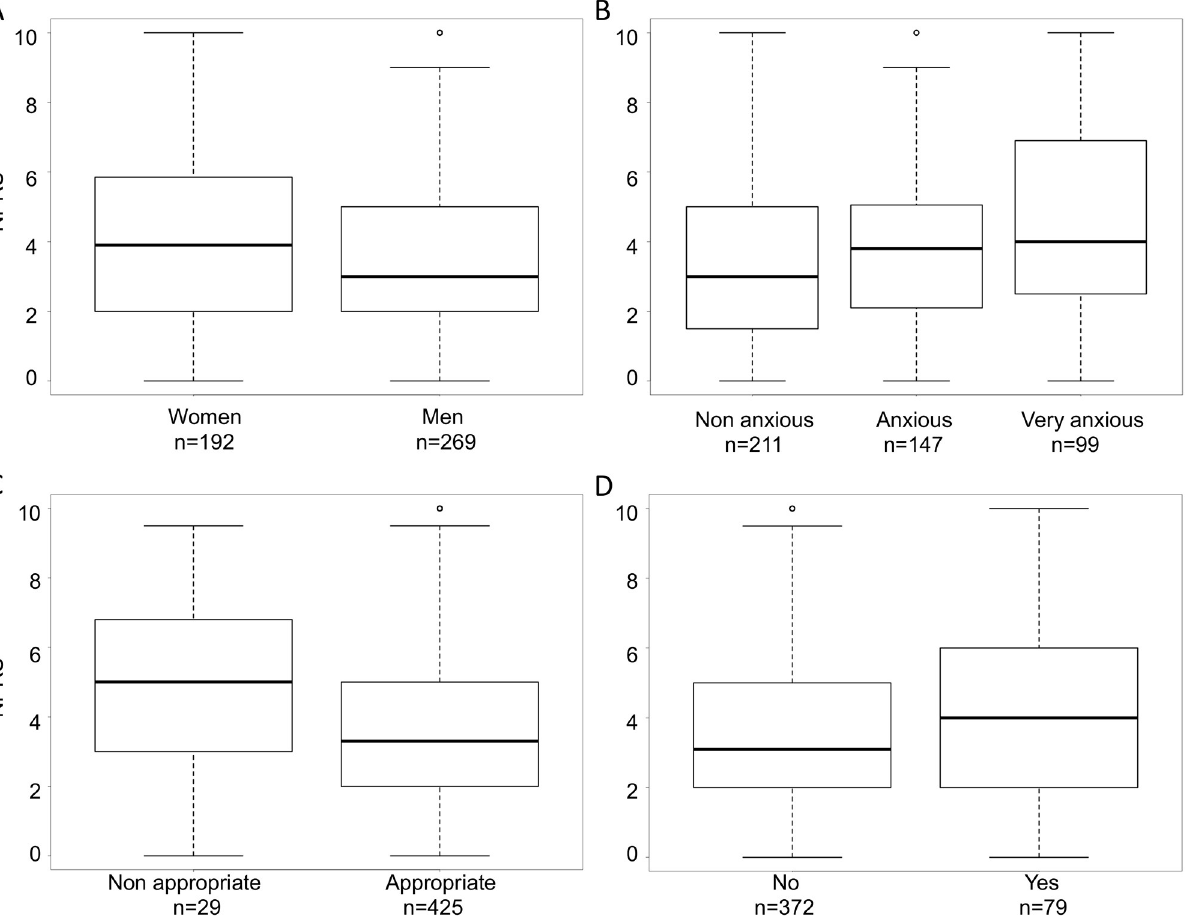
Fig 4. Factors influencing NRPS score during BMA (sternal and iliac crest site). Effect on sex (A), anxiety evaluated by the patient (B), quality of information received during BMA procedure (C) and bone texture (D) on NPRS score. Boxplots represent median values (horizontal line) and whiskers the 5 th and 95 th